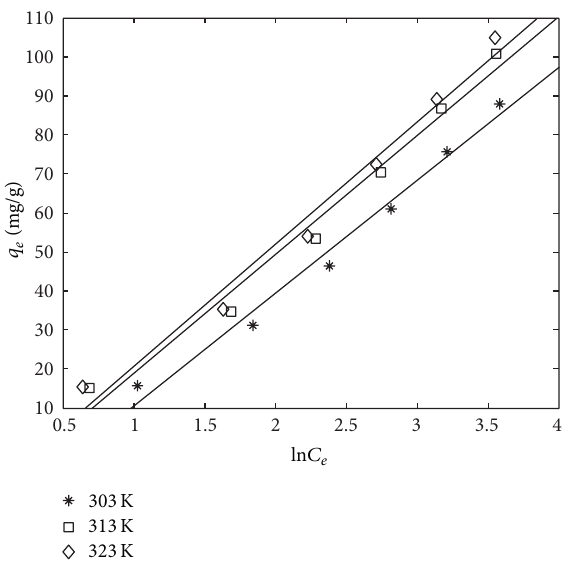
Figure11:Linearizedgeneralizedisothermatdifferenttemperatures ( 𝑀 : 0.3 g; pH: 6; agitation rpm: 150).